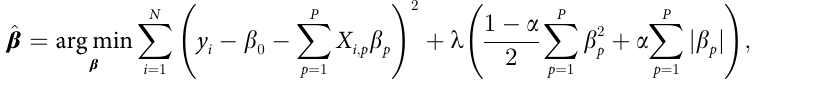
Fig 5. DBM forecasts for validation ILI for the 2014 flu season for Region 2. Posterior predictive summaries of ỹ available ILI for each panel. Notice there is forecast uncertainty even for weeks where available ILI exists, accounting for